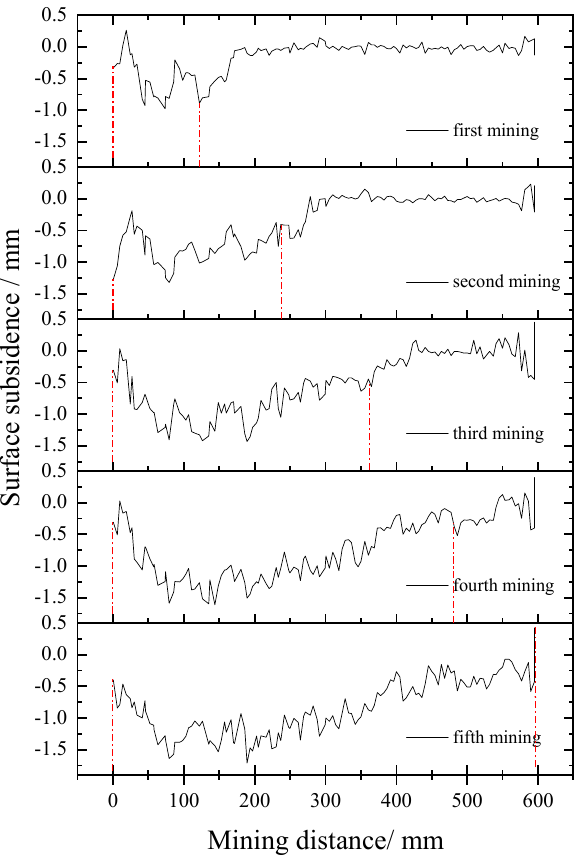
Figure 10. Monitoring curves of surface measuring line settlement.